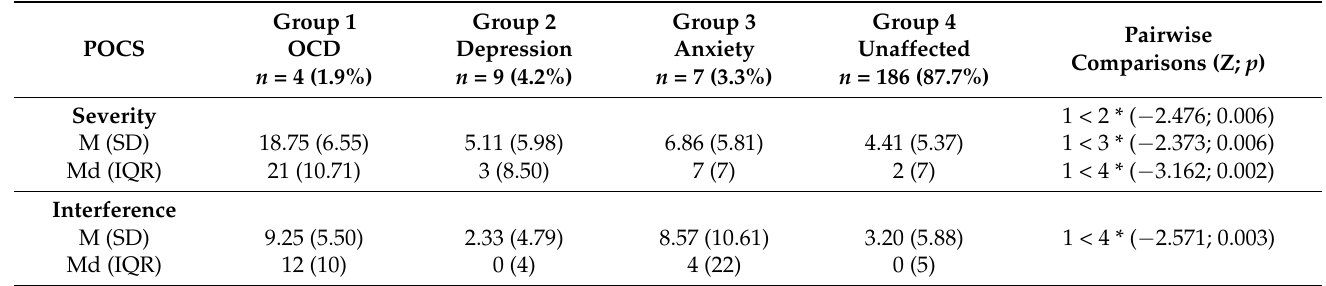
Table 3. POCS scores by diagnostic groups/DSM-5—Mann–Whitney U.